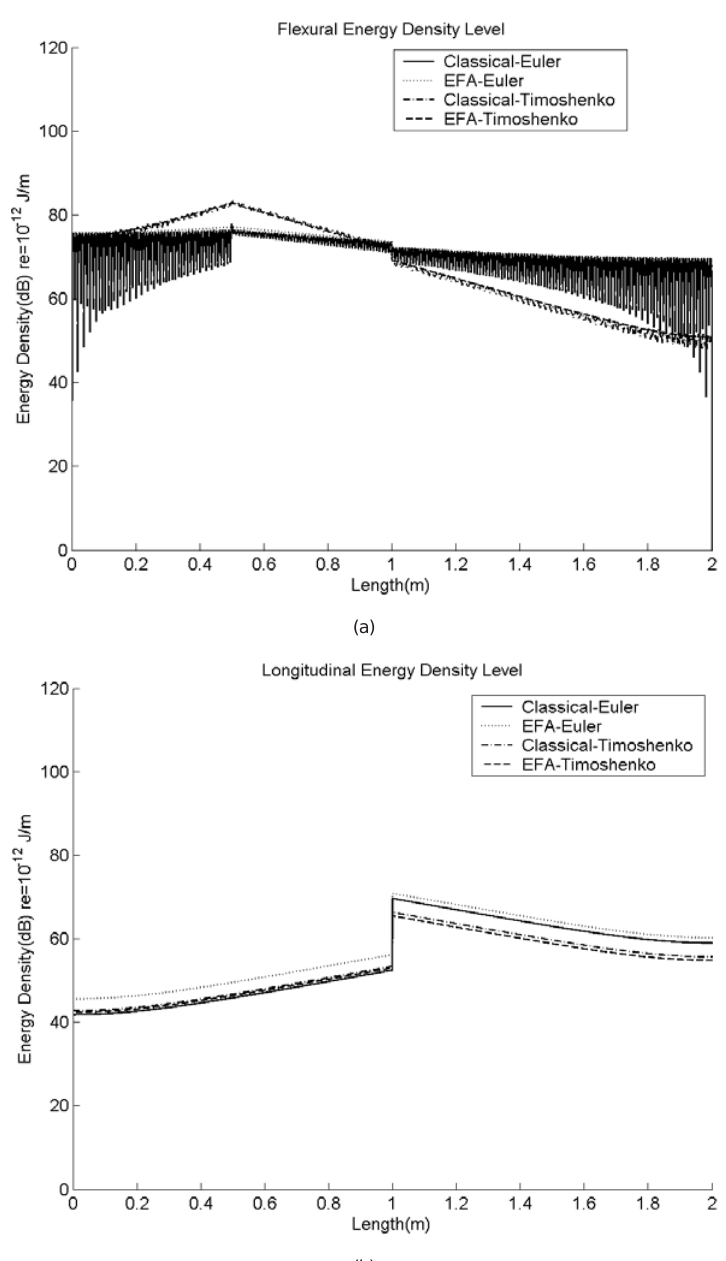
Fig. 12. The comparison of the time- and locally space-averaged energy and power levels of two Timoshenko beam with two Euler-Bernoulli beam structures coupled with θ = 45 ◦ when f = 250 kHz, η = 0 . 01 . The reference energy density is 1 × 10 − 12 J / m and the reference power is 1 × 10 − 12 W; (a) Flexural energy, (b) Longitudinal energy, (c) Flexural power, (d) Longitudinal